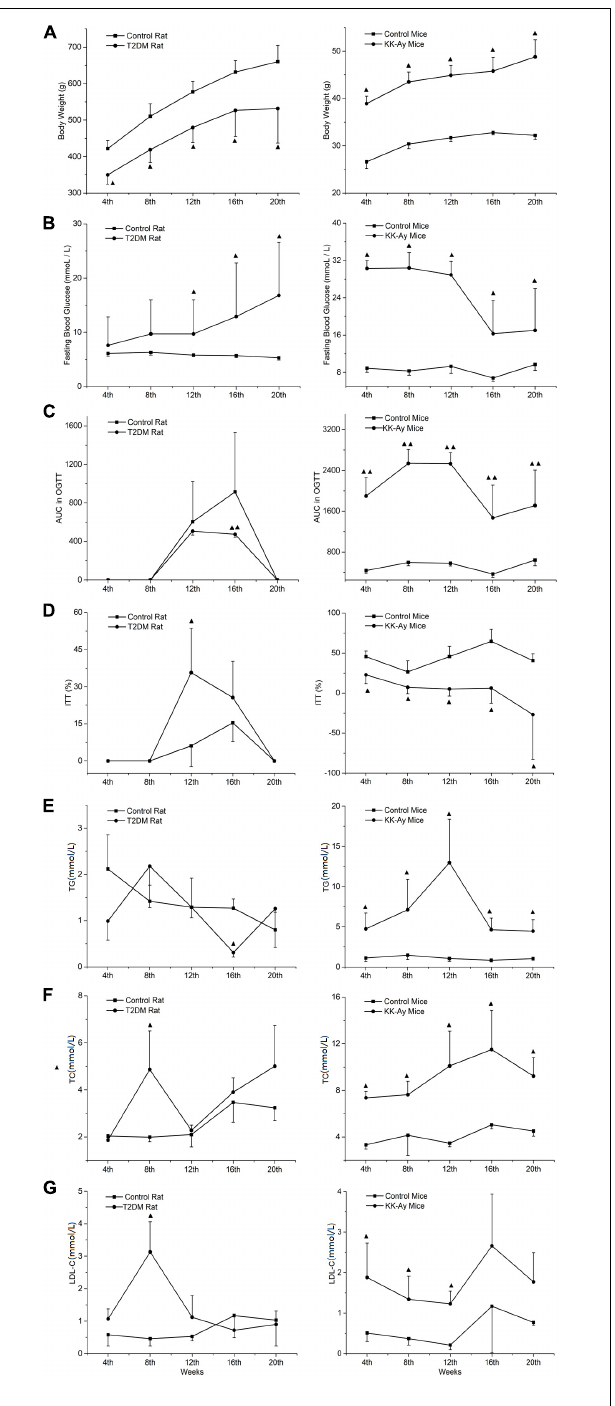
FIGURE 3 | Comparisons on the dynamic changes of glucose and lipid metabolic parameters in T2DM rats and KK-Ay mice. (A–G) The dynamic changes of body weight (A) , FBG (B) , AUC in OGCT (C) , percentage of ITT (D) , TG (E) , TC (F) , and LDL-C (G) in T2DM rats (left) and KK-Ay mice (right) along with the indicated time points after the initial of modeling are shown. (cid:78) P < 0.05, (cid:78)(cid:78) P < 0.01, compared with the corresponding control group at the same time point. FBG, fasting blood glucose; OGCT, oral glucose challenge test; ITT, insulin tolerance test; AUC, area under the curve; TG, triglyceride; TC, total cholesterol; LDL-C, low-density lipoprotein-cholesterol.